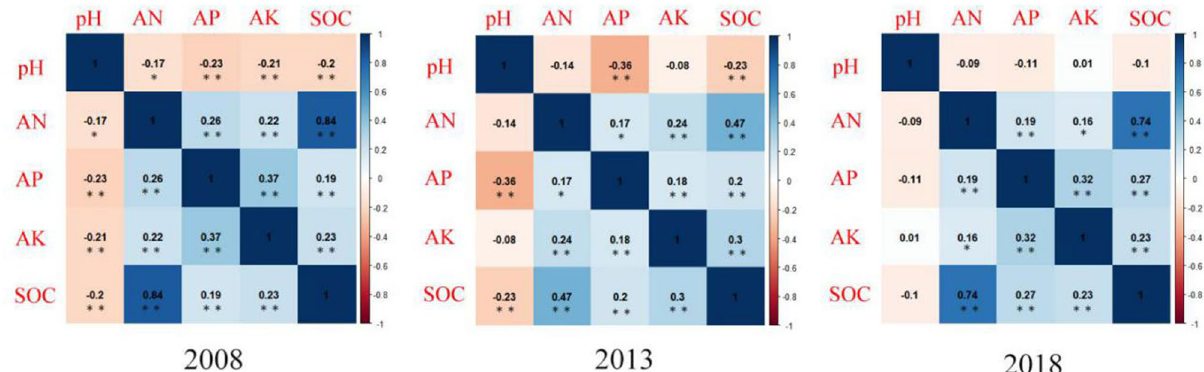
Figure 1. Pearson correlation among soil properties in 2008, 2013 and 2018. Color depicts the direction of the correlation (blue = positive, red = negative). P-values in black color are significant (* P < 0.05, ** P < 0.01). The correlation coefficients are shown in the panel. AN available nitrogen, AP available phosphorus, AK available potassium, SOC soil organic